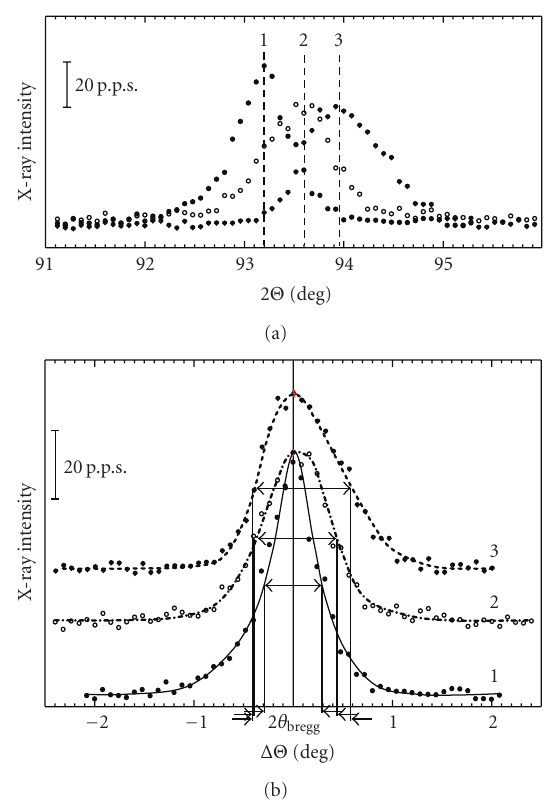
Figure 3: Position (a) and shape (b) of the (211) B2 peak in the TiNi specimen: before irradiation (1), after irradiation with E 1 = 4J/cm 2 , N = 20 pulses (2) and with E 2 = 8 J/cm 2 , N = 50 pulses (3). The Bragg di ff raction geometry, Co-K α radiation, entrance and exit horizontal slits of width 0.1